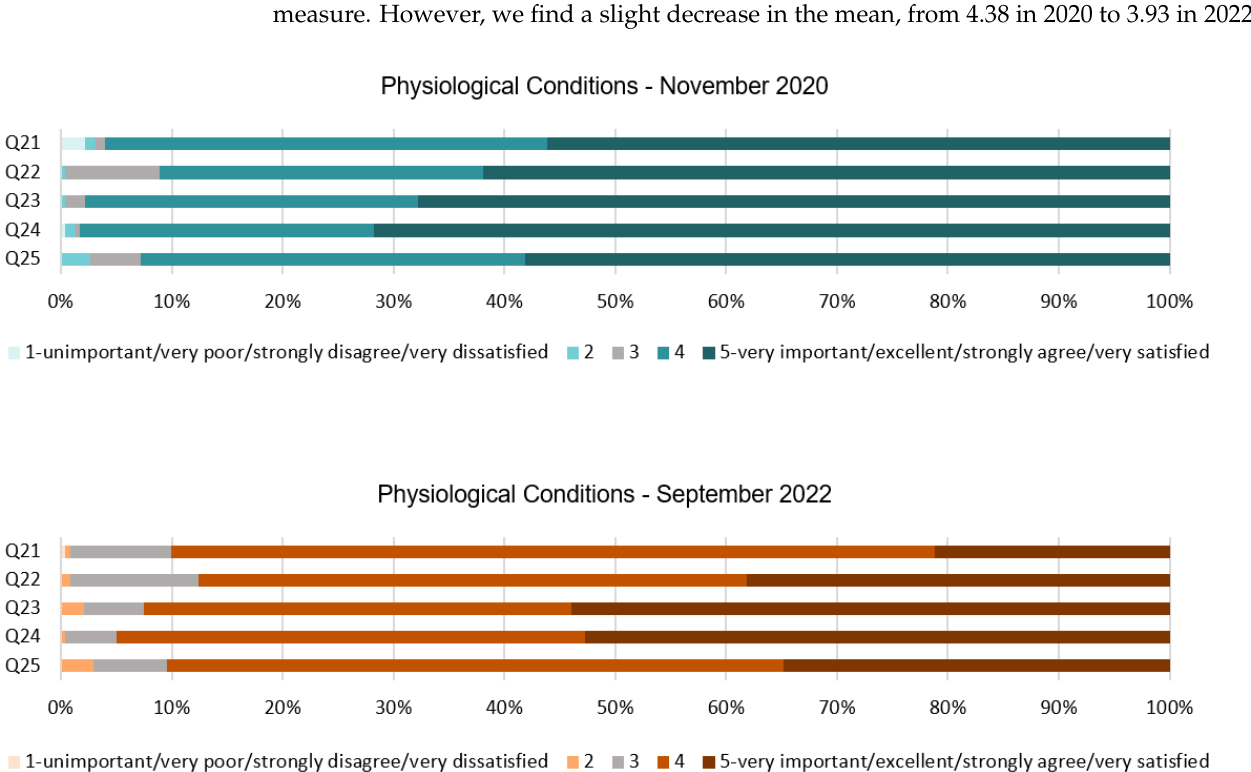
Figure 10. Physiological Conditions dimension chart.